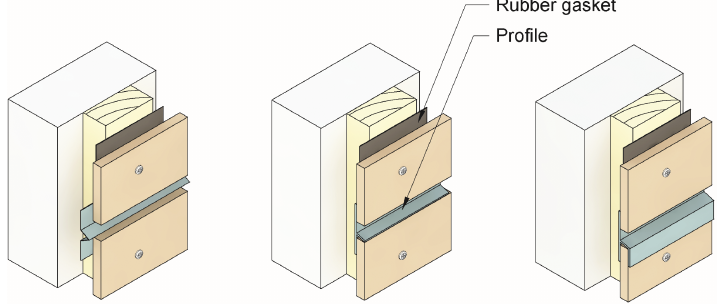
Figure 3. Joint profiles within the joint. From the left: T1-profile, T2-profile, and